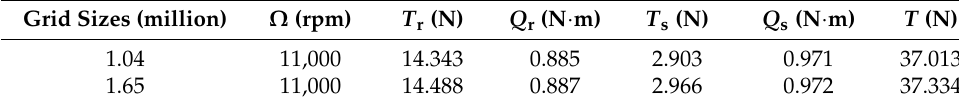
Table 2. Performance comparison of the ducted fan with different background grids. Grid Sizes (million)